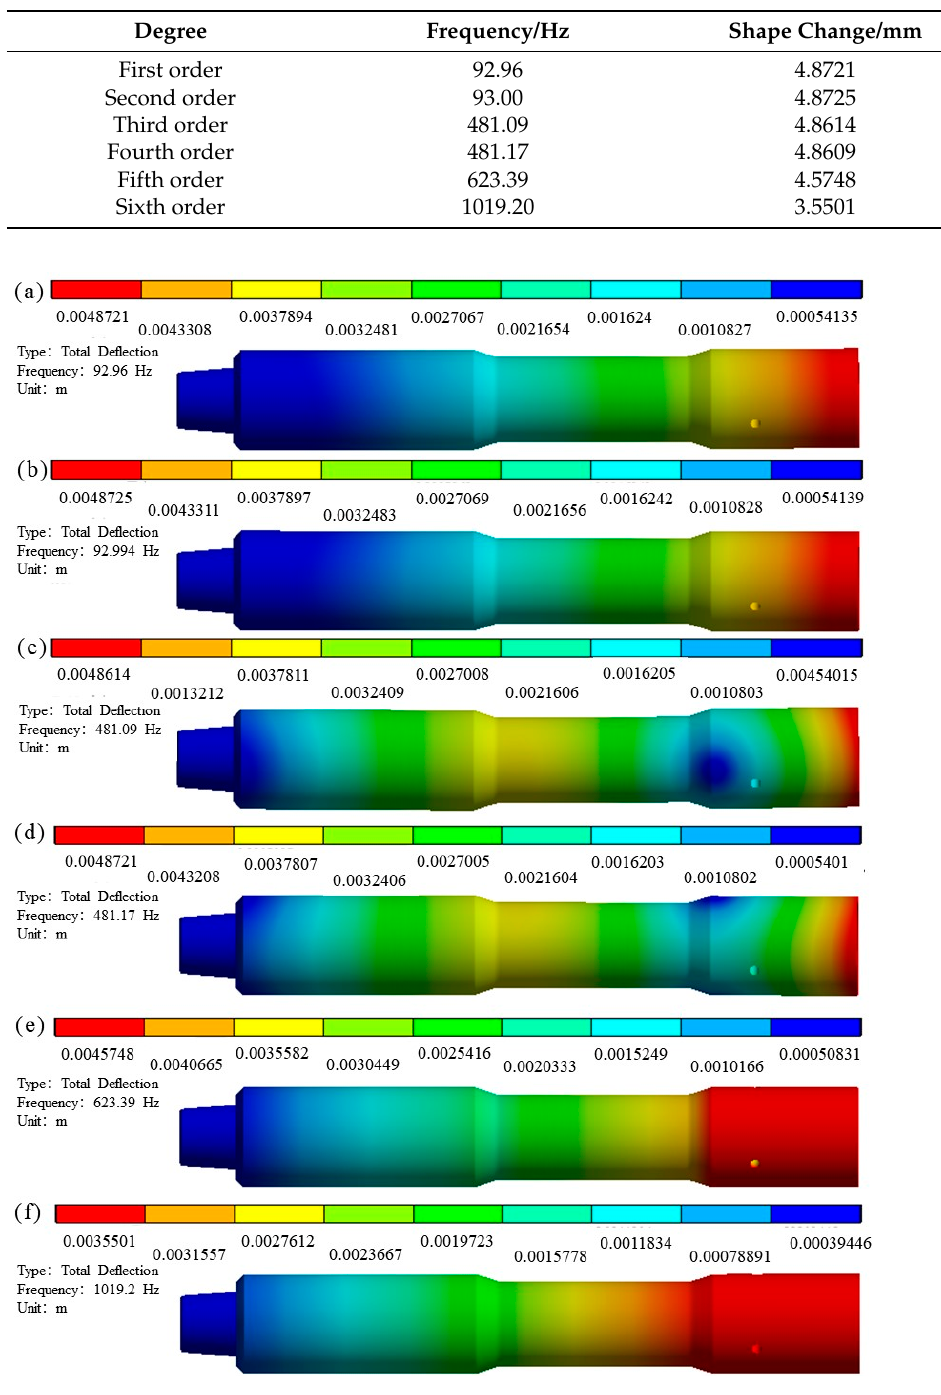
9 of 14 Figure 5. Deformation and stress diagram of downhole solid–liquid separator. ( a ) Deformation dis- tribution; ( b ) stress distribution.